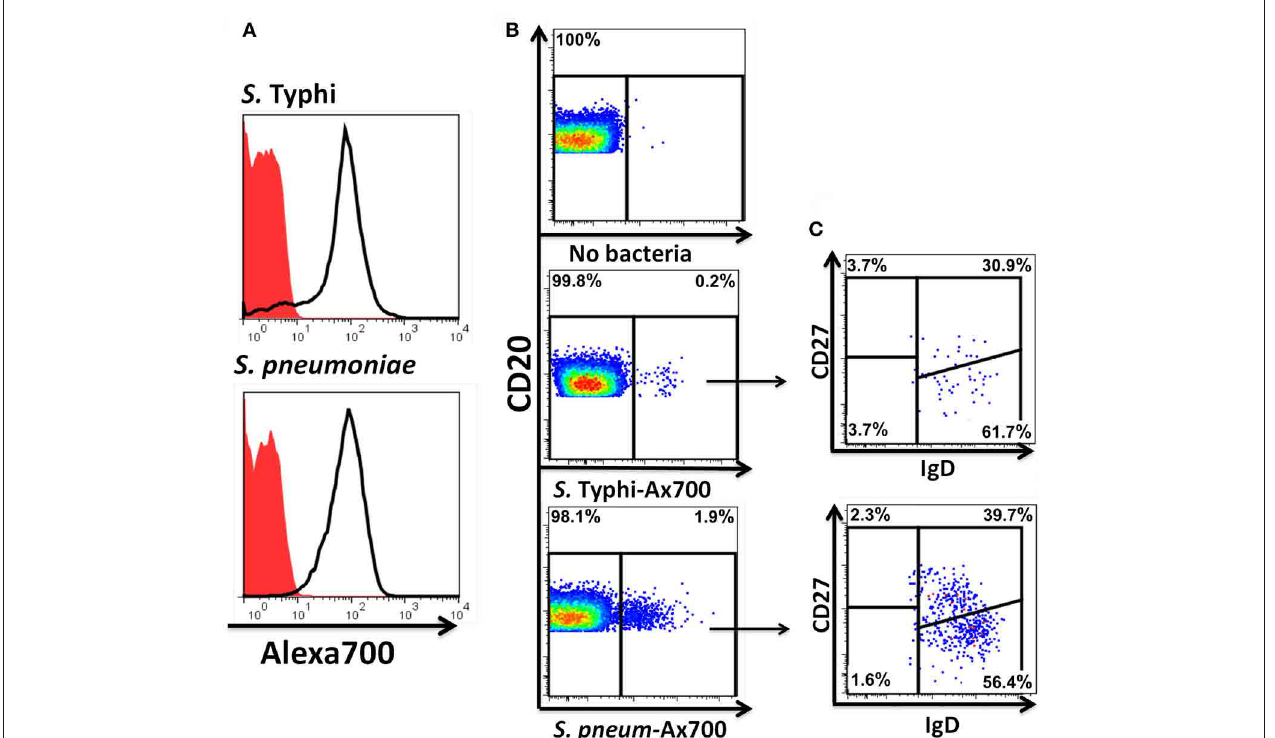
FIGURE 9 | Fluorescently labeled bacteria bind preferentially to naïve and Um B cells. Heat-killed S . Typhi (gram negative) and S. pneumoniae (encapsulated gram positive) bacteria were fluorescently labeled with Alexa700 (A) . Unstained bacteria (red closed histograms) and stained bacteria (continuous lines) are shown in panel A . PBMC were incubated